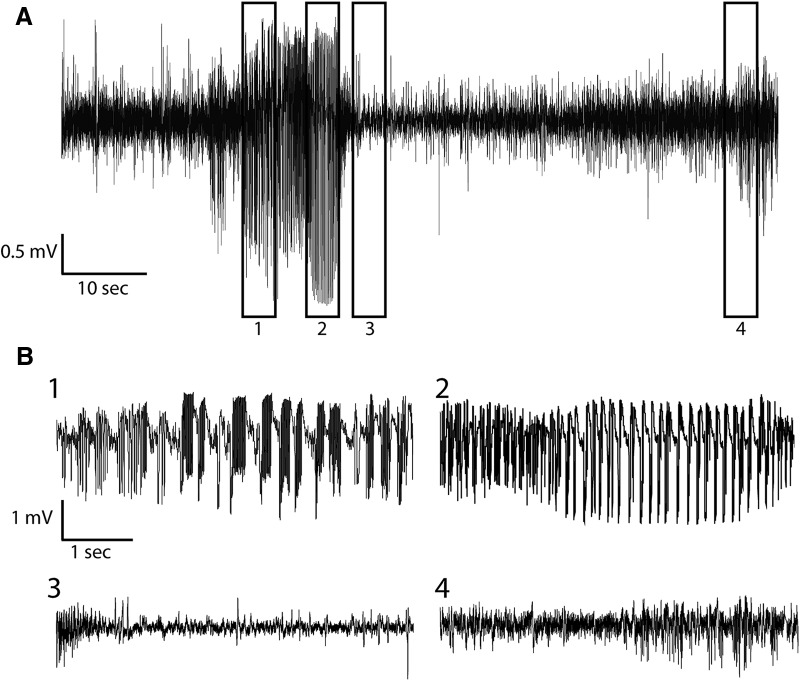
Targeted interneuron ablation produces seizures. A, Example of a seizure recorded in the dorsal CA1 region of the hippocampus using a miniature wireless telemetry recording device mounted to the animal’s head with an electrode positioned near the CA1 pyramidal cell layer. B, Expansion of the boxed regions of the recording in A demonstrating the changes in the recorded waveforms during the seizure (1 and 2), the postictal depression (3), and return to normal baseline activity (4).